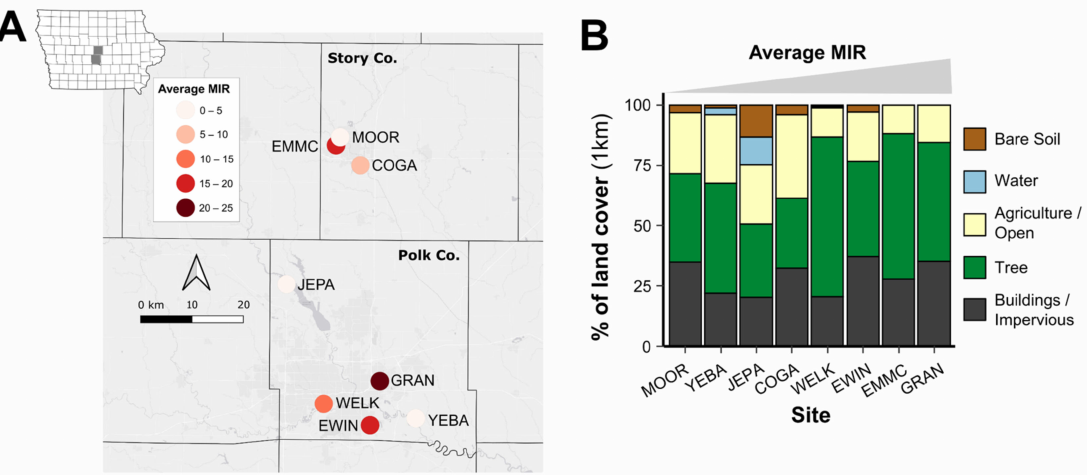
Figure 1. Minimum infection rates and landscape ecologies vary across mosquito trapping site locations. Study site locations in central Iowa showed substantial variation in mosquito minimum infection rates (MIRs, averaged from 2016–2018) ( A ) and displayed a wide range of landscapes, with land use classifications calculated by remote sensing within 1 km of trap sites ( B